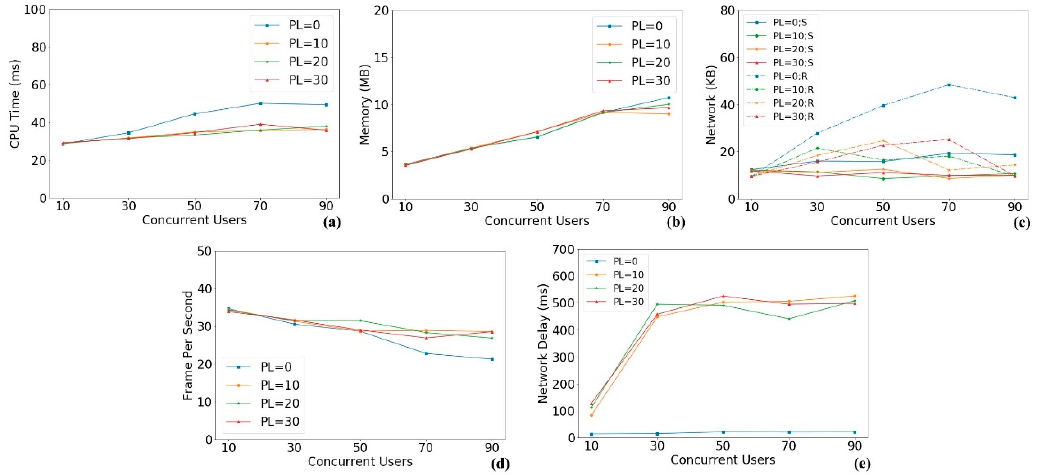
Figure 11. All-in-one VR resource consumption for different numbers of concurrent users and packet lags: ( a ) CPU percentage; ( b ) memory; ( c ) network; ( d ) framerate per second; ( e ) network delay.